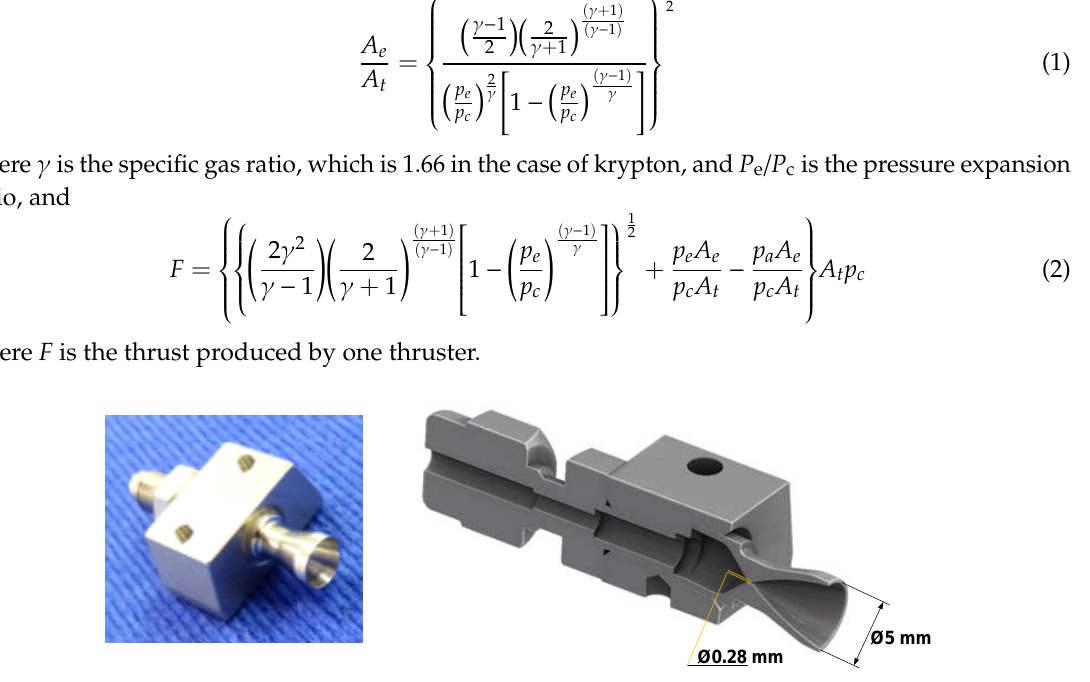
Figure 9. Left : Photograph of the Adelis-SAMSON nano-satellite thruster nozzle. Right : Illustration of a cross section of the Adelis-SAMSON nano-satellite thruster assembly showing its leading dimensions. Equations (1) and (2) yield the projected thrust of 20.2 mN, which meets the mission thrust requirement per